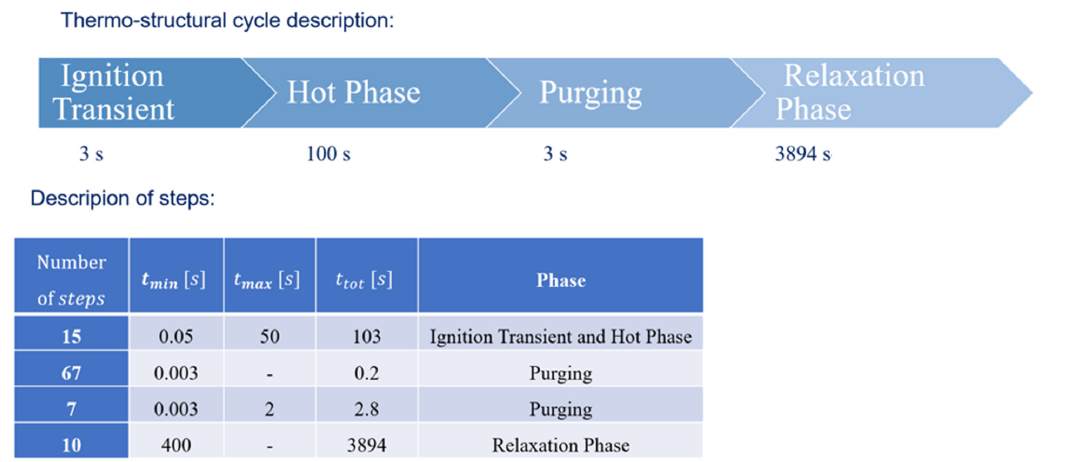
Figure 8. Thermo-structural cycle description.